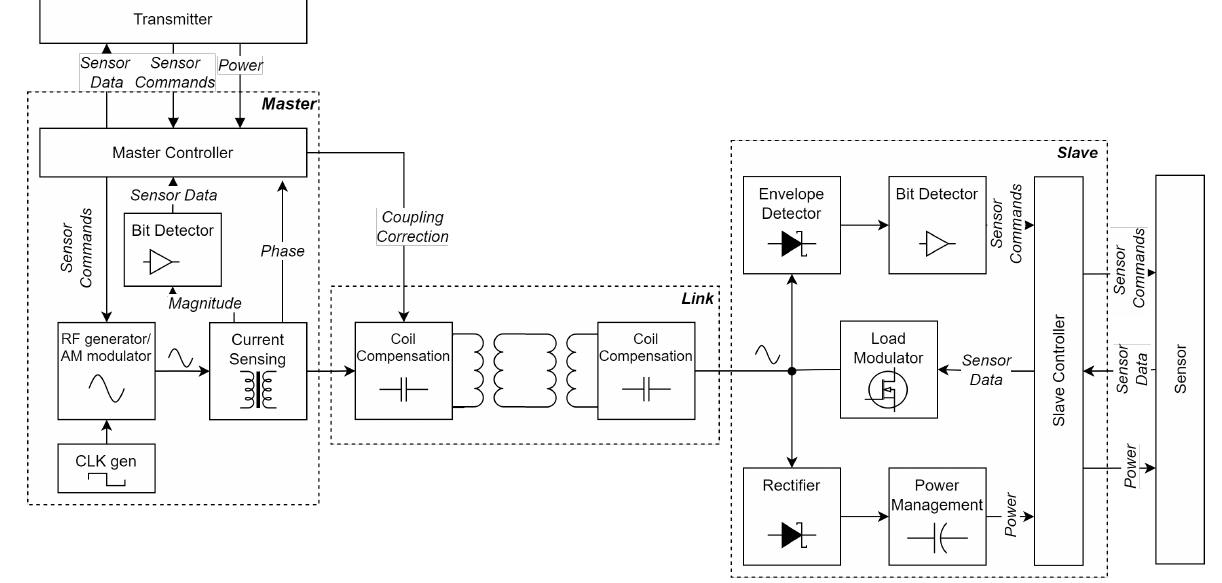
Figure 2. Block diagram of all the subsystems.